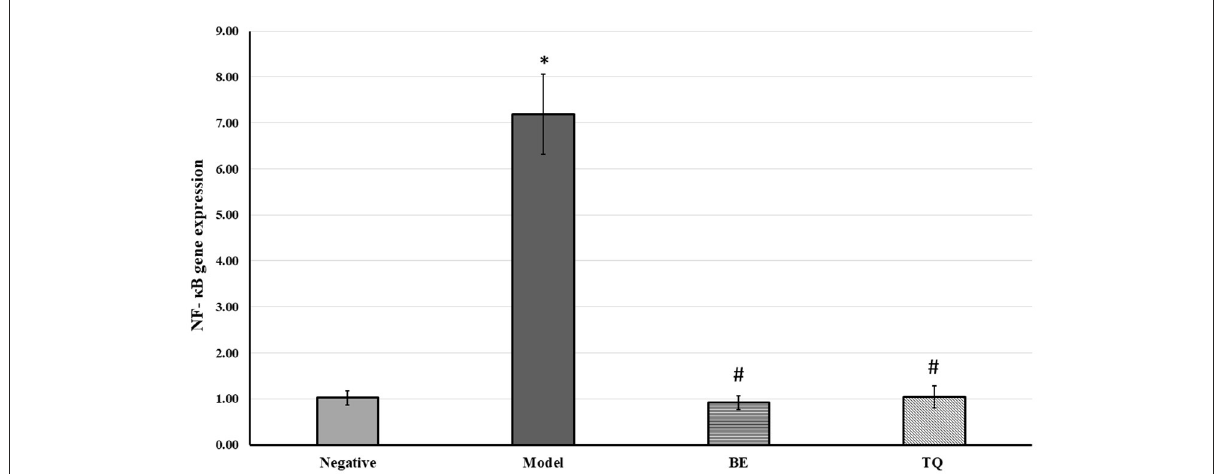
FIGURE3 The effects of BE (30 mg/kg/day) and TQ (25 mg/kg/day) on tissue NF- κ B gene expression. * Denotes a significant difference compared to the negative group ( p < 0.001). # Denotes a0101 significant difference compared to the model group ( p < 0.0010101). BE, Berbamine; TQ, Thymoquinone ( n =